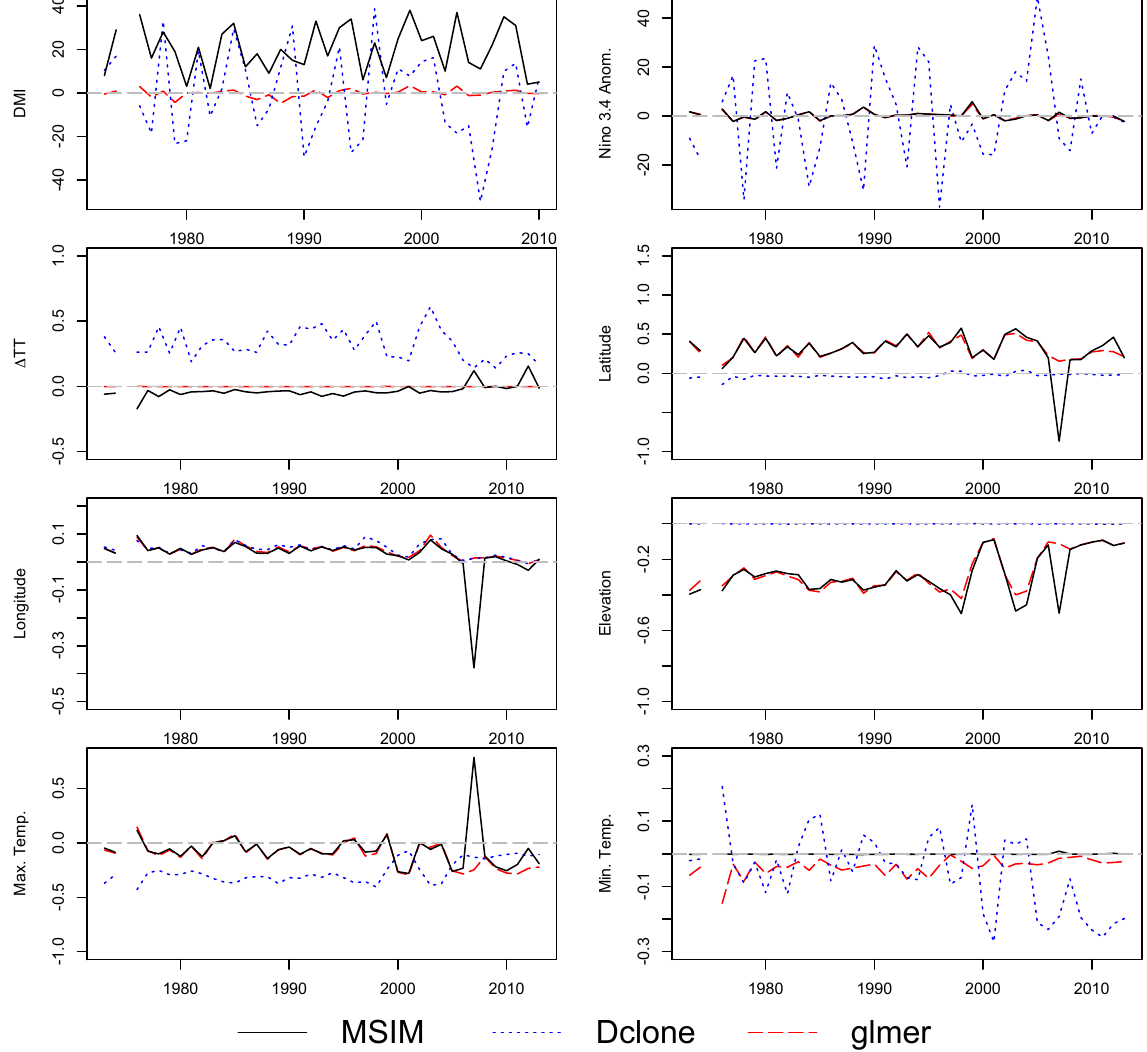
Figure 3. Fixed coefficient estimates for logit-normal models with light Indian rainfall (0 <x < 64.4mmday − 1 ) response from 1973–2013.